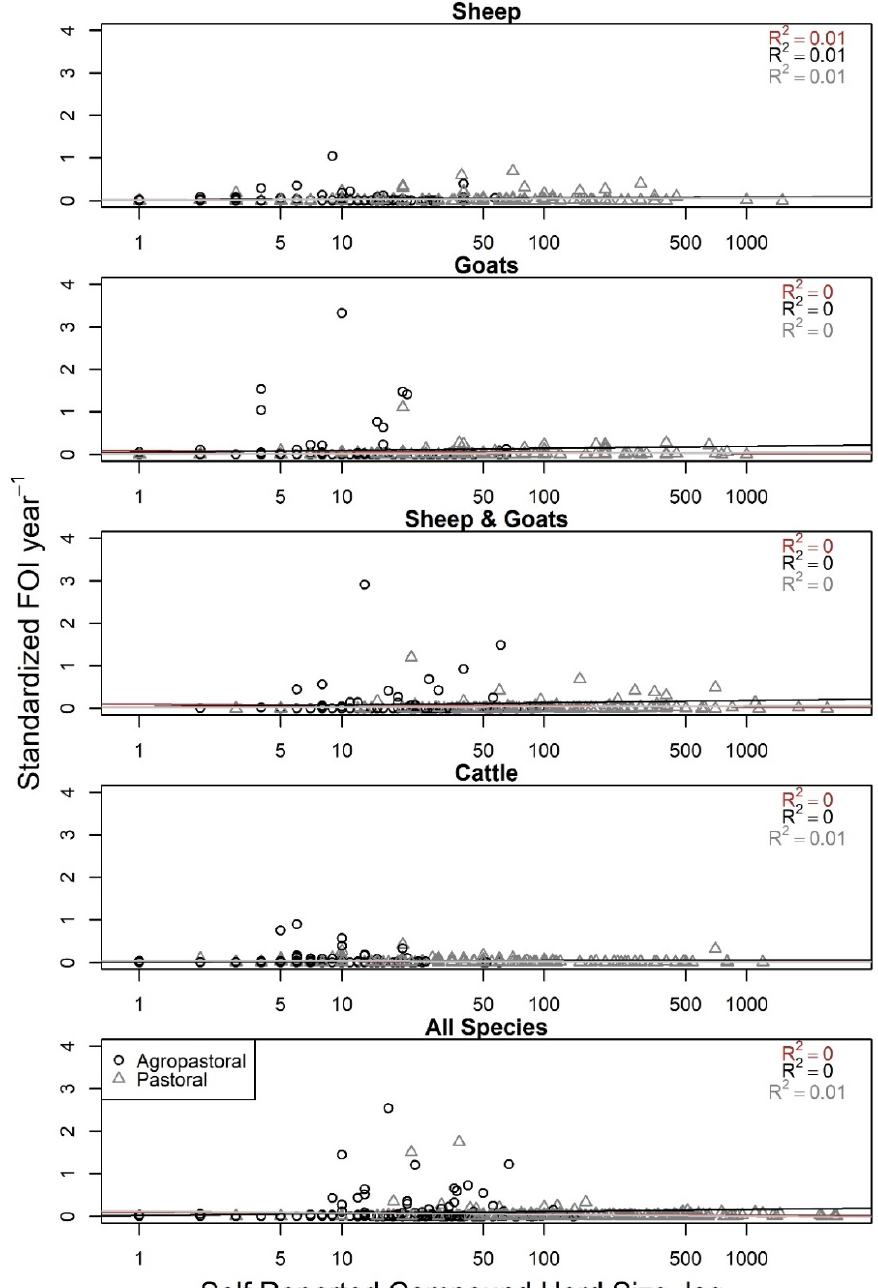
Figure 3. Compound herd force of infection (FOI, year − 1 ) is not associated with increasing self-reported compound herd size (log 10 ), consistent with overall frequency-dependent scaling of transmission patterns for Peste des petits ruminants virus in the compound herd. FOI values for each household/compound herd were obtained from species-specific (top four panels) or an all-species generalized linear mixed model with household as a random effect and sex and production type as fixed effects. Agropastoral compounds are represented by black, open circles; pastoral compounds by gray, open triangles. Linear models were fit to each and resulting adjusted R 2 is reported for each production type and overall (brown). As the linear models were flat with little to no association, this matches the expected FOI pattern for frequency-dependence (constant), but not density-dependence (increasing).